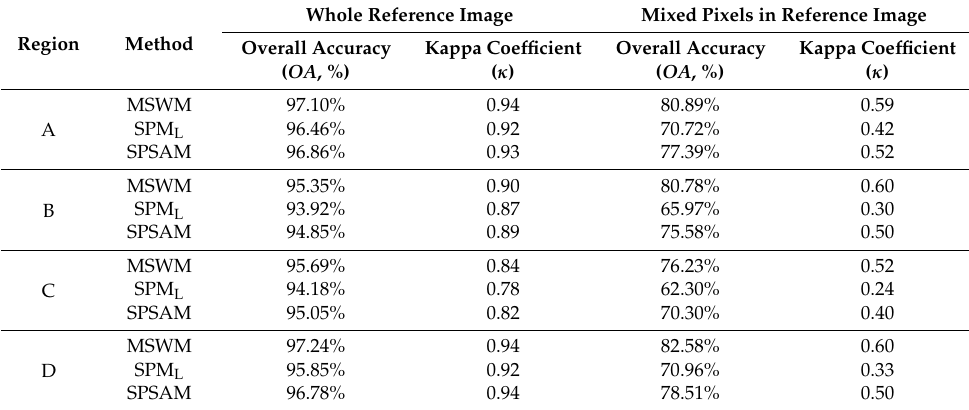
Table 1. Comparisons of subpixel water mapping accuracy among MSMM, SPM L , and SPSAM.